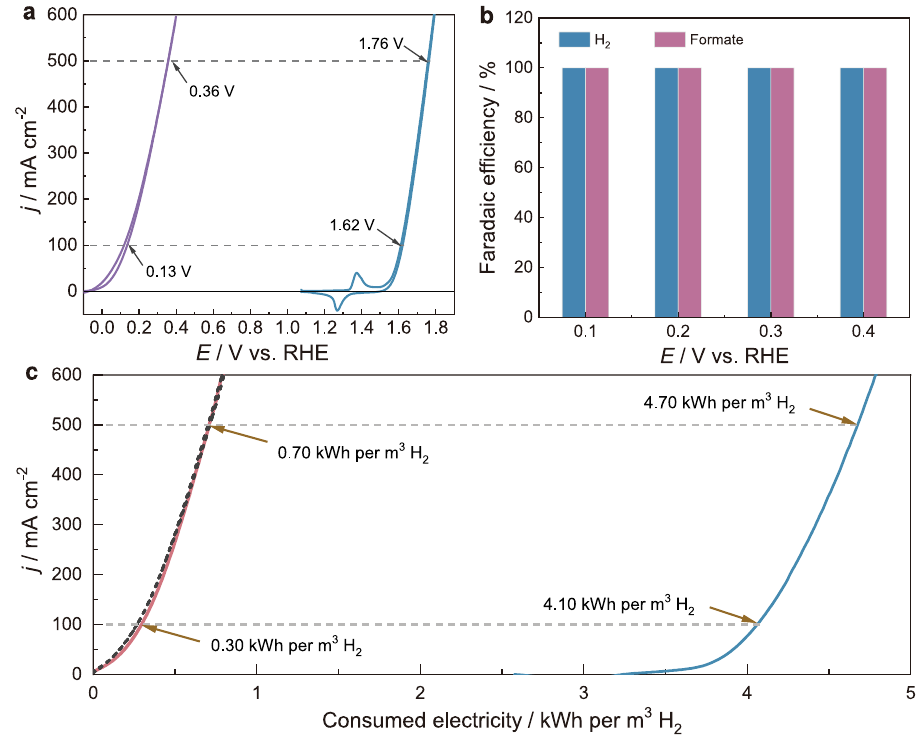
Fig. 6 | Electrocatalytic paraformaldehyde oxidation and energy ef fi ciency analysis. a CV curves of Cu 3 Ag 7 /CF (red) in 1.0M KOH with 10.0g/L paraf- ormaldehyde and Ni/NF (blue) in 1.0M KOH collected at 10mV/s. b Faradaic ef fi - ciencies of H 2 and formate production in the anode chamber during each electrolysisatdifferent potentials using Cu 3 Ag 7 /CF as the anode, 1.0M KOH asthe